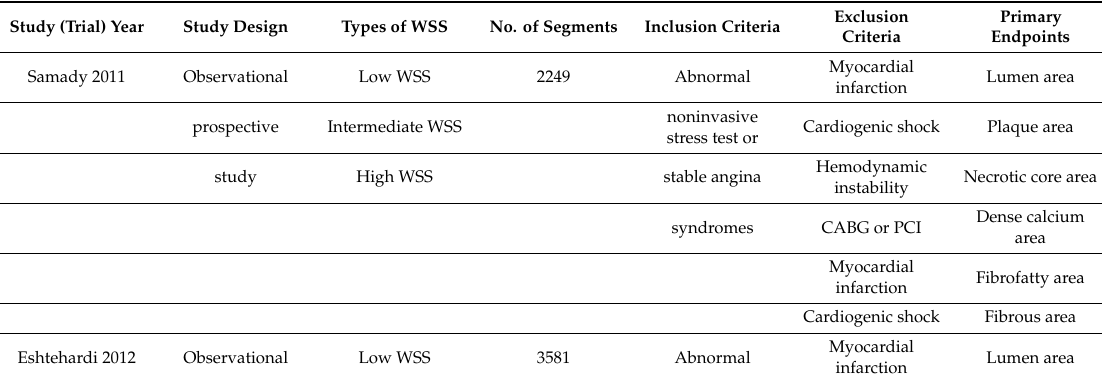
Table 1. Main characteristics of trials included in the